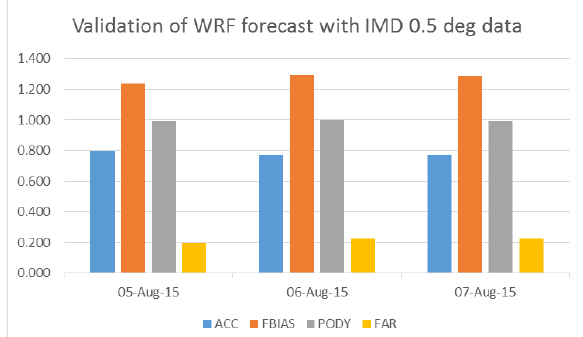
Figure 5. Rainfall prediction above 100 mm statistical outputs form MET tool (ACC: accuracy; FBIAS: frequency of bias; PODY: probability of detection; FAR: False Alarm